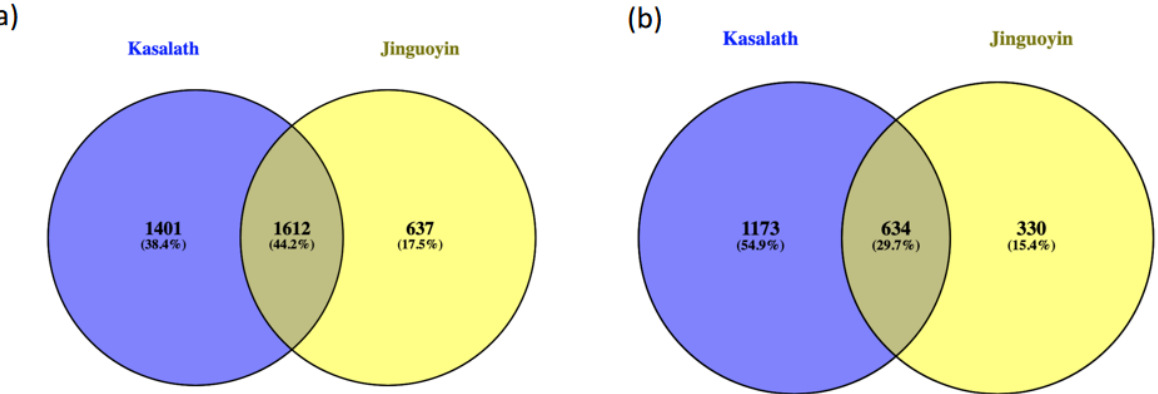
Figure 5. Numbers of differential expressed genes induced by Al. Genes up- ( a ) and downregulated ( b ) by Al in Kasalath and Jinguoyin. Four-day-old seedlings were exposed to a 0.5 mM CaCl 2 (pH 4.5) solution containing 0 or 50 μM Al. After 6 h, the root tips (0–1 cm) were excited and subjected to RNA-seq analysis. Genes where the expression is significantly higher than two folds are shown (adjusted p -value of <0.05).